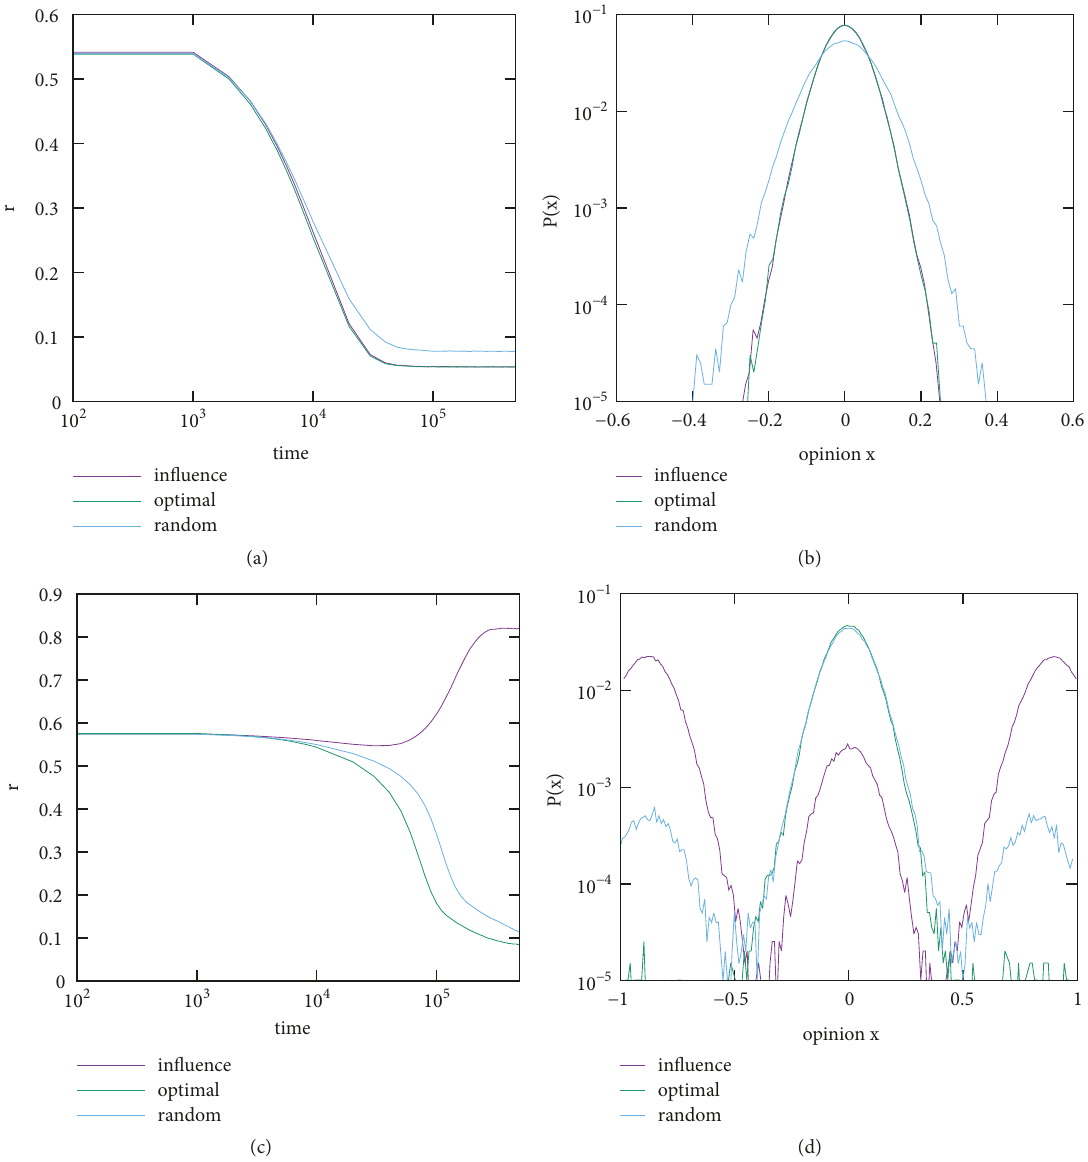
Figure 7: Different equilibrium outcomes for the influenced opinion dynamics for different settings of the tolerance parameter 훿 for the scenario of two external controllers with opinions ±1 : averaged time dependence of the opinion dispersion 푟 for (a) 훿 = 1.5 and (c) 훿 = 0.6 and stationary distributions of the opinions in equilibrium for (b) 훿 = 1.5 and (d) 훿 = 0.6 . The figures compare three different settings for rewiring: competitive influence maximization (influence), rewiring to reduce 푟 (optimal), and random rewiring (random). Results are averaged over 50 independent runs for a system of 푁 = 1000 nodes, noise Δ = 0.001 , ⟨푘⟩ = 10 , and 푚 = 1